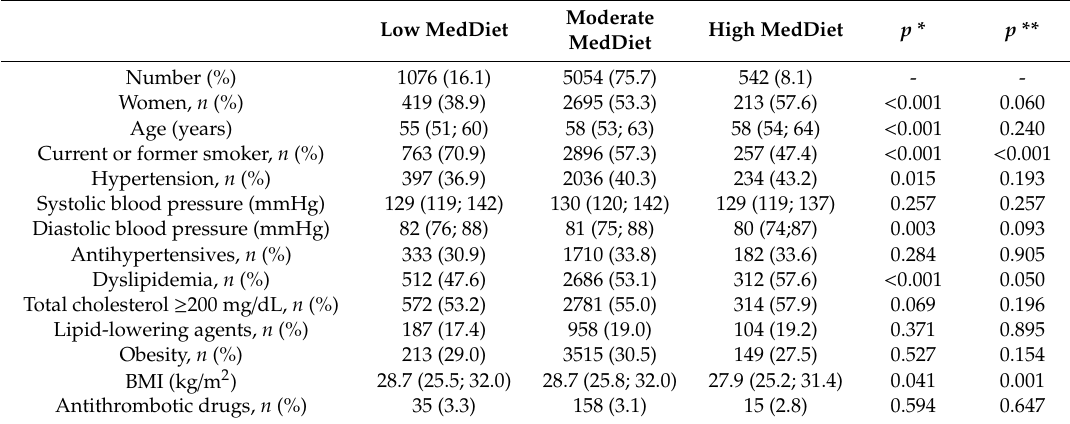
Table 2. Main clinical characteristics and comorbidities of the study population according to their adherence to the Mediterranean